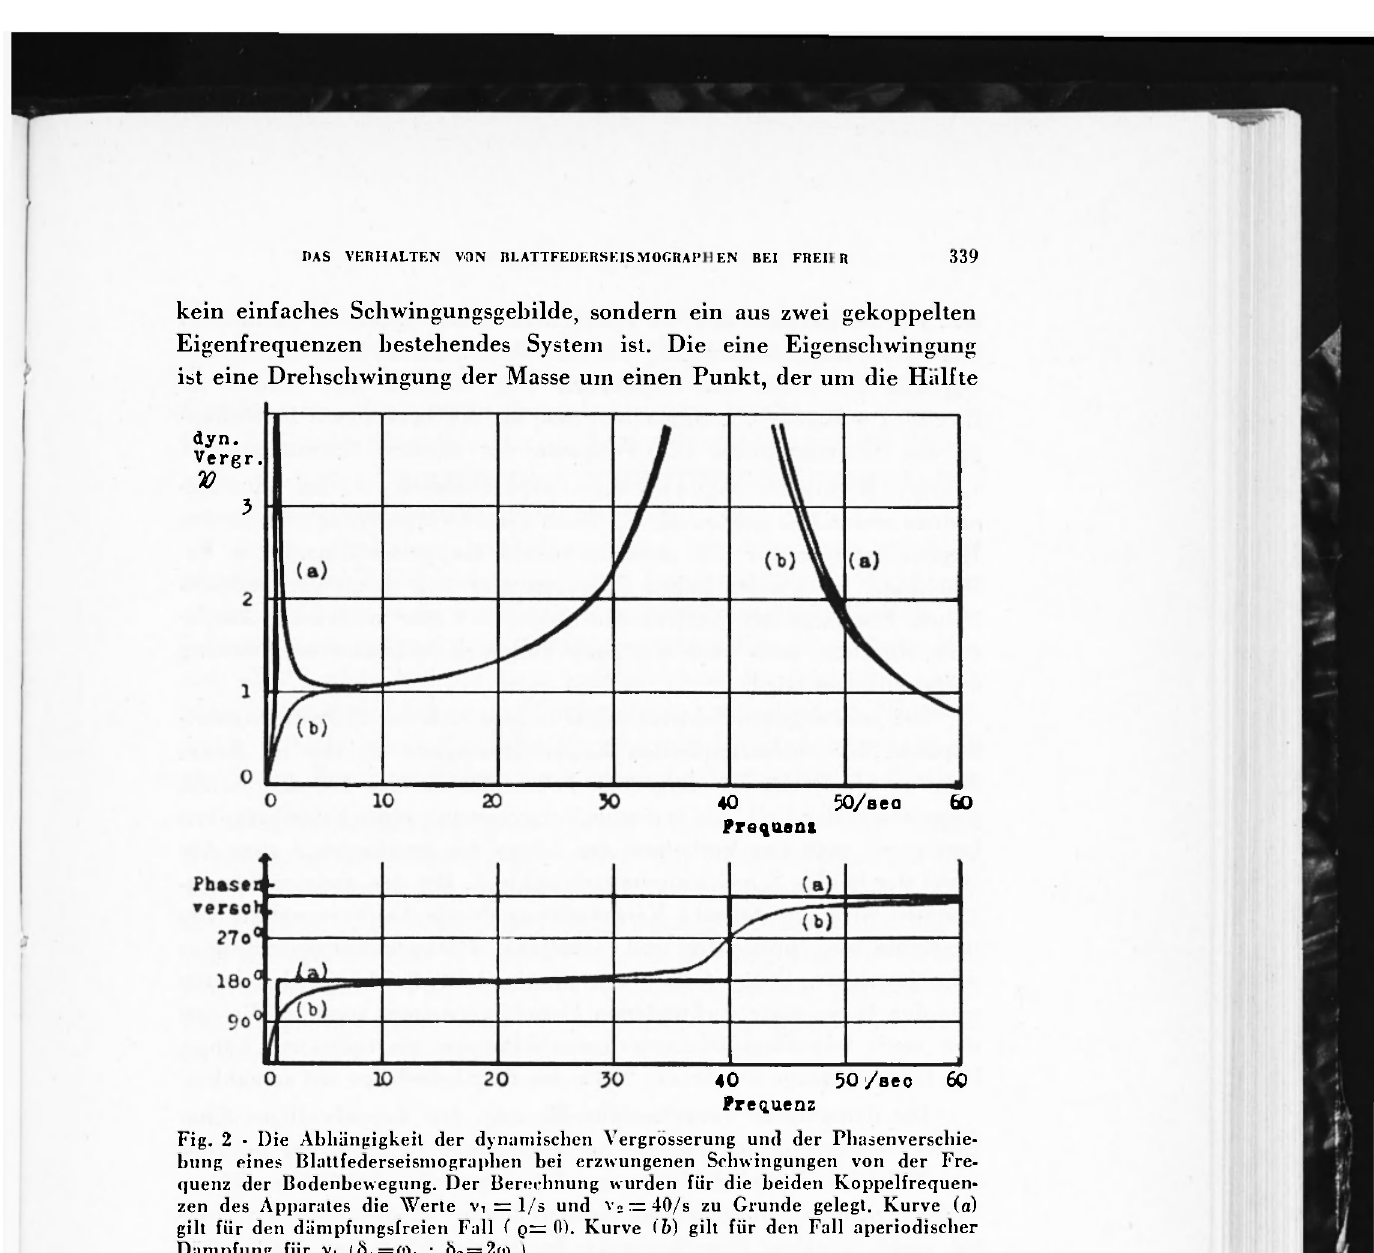
Fig. 2 • Die Abliiingigkeil der dynamischen Vergrosserung und der Phasenverschie- bung eine? Blattfederseisniographen bei erzwungenen Schwingungen von der Fre- quenz der Bodenbewegung. Der Bereehnung wurden fiir die beiden Koppelfrequen- zen des Apparates die Werte Vi = 1/s und v : = 4Q/s zu Grunde gelegt. Kurve (a) gilt fiir den diimpfungsfreien Fall ( q= 0). Kurve ( 6) gilt fiir den Fall aperiodischer Dampfung fiir (8, = co, ; 6 2 =